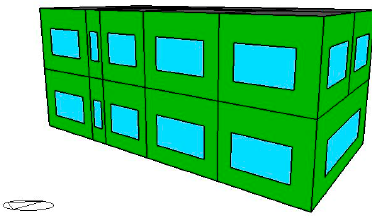
Figure 1. Tridimensional model of the office building.